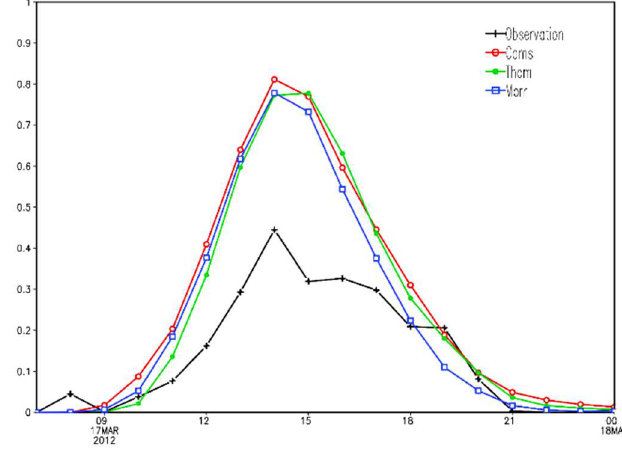
Figure 2. Hourly third domain averaged snowfall distributions of the simulations of the three cloud schemes and observations (mm/h).